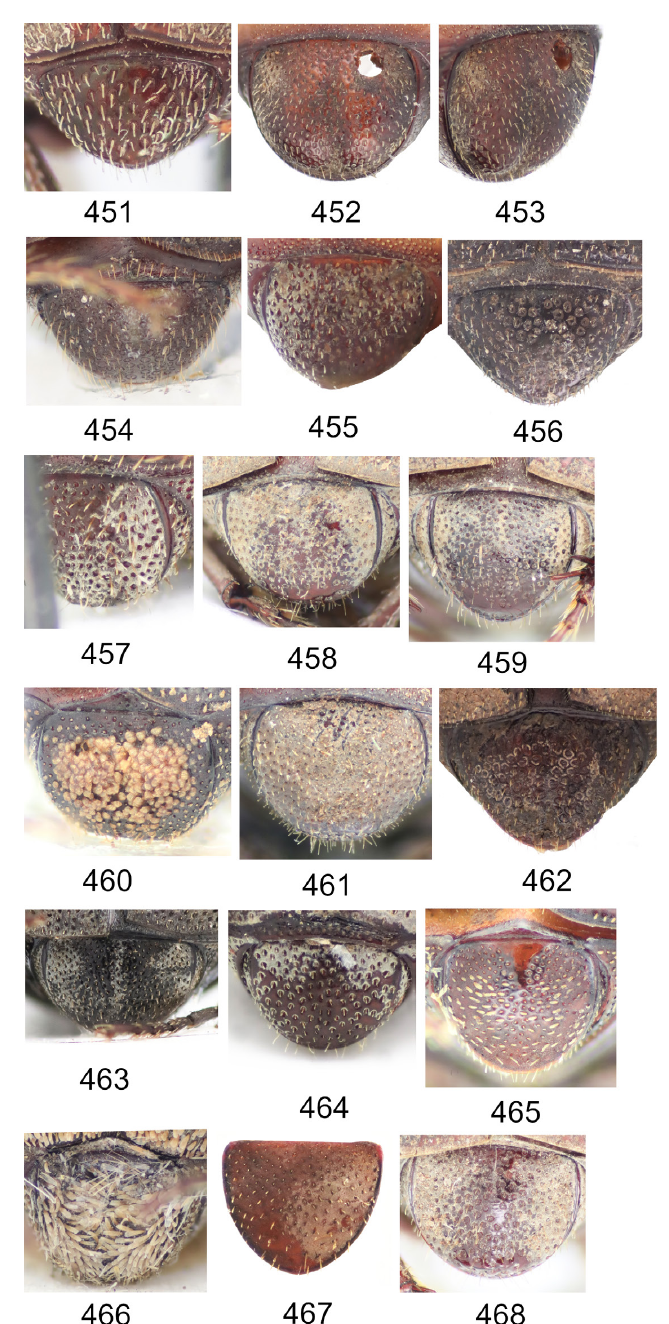
Figs 451–468. Papuan and Wallacean Maechidius Macleay, 1819, pygidium, dorsal